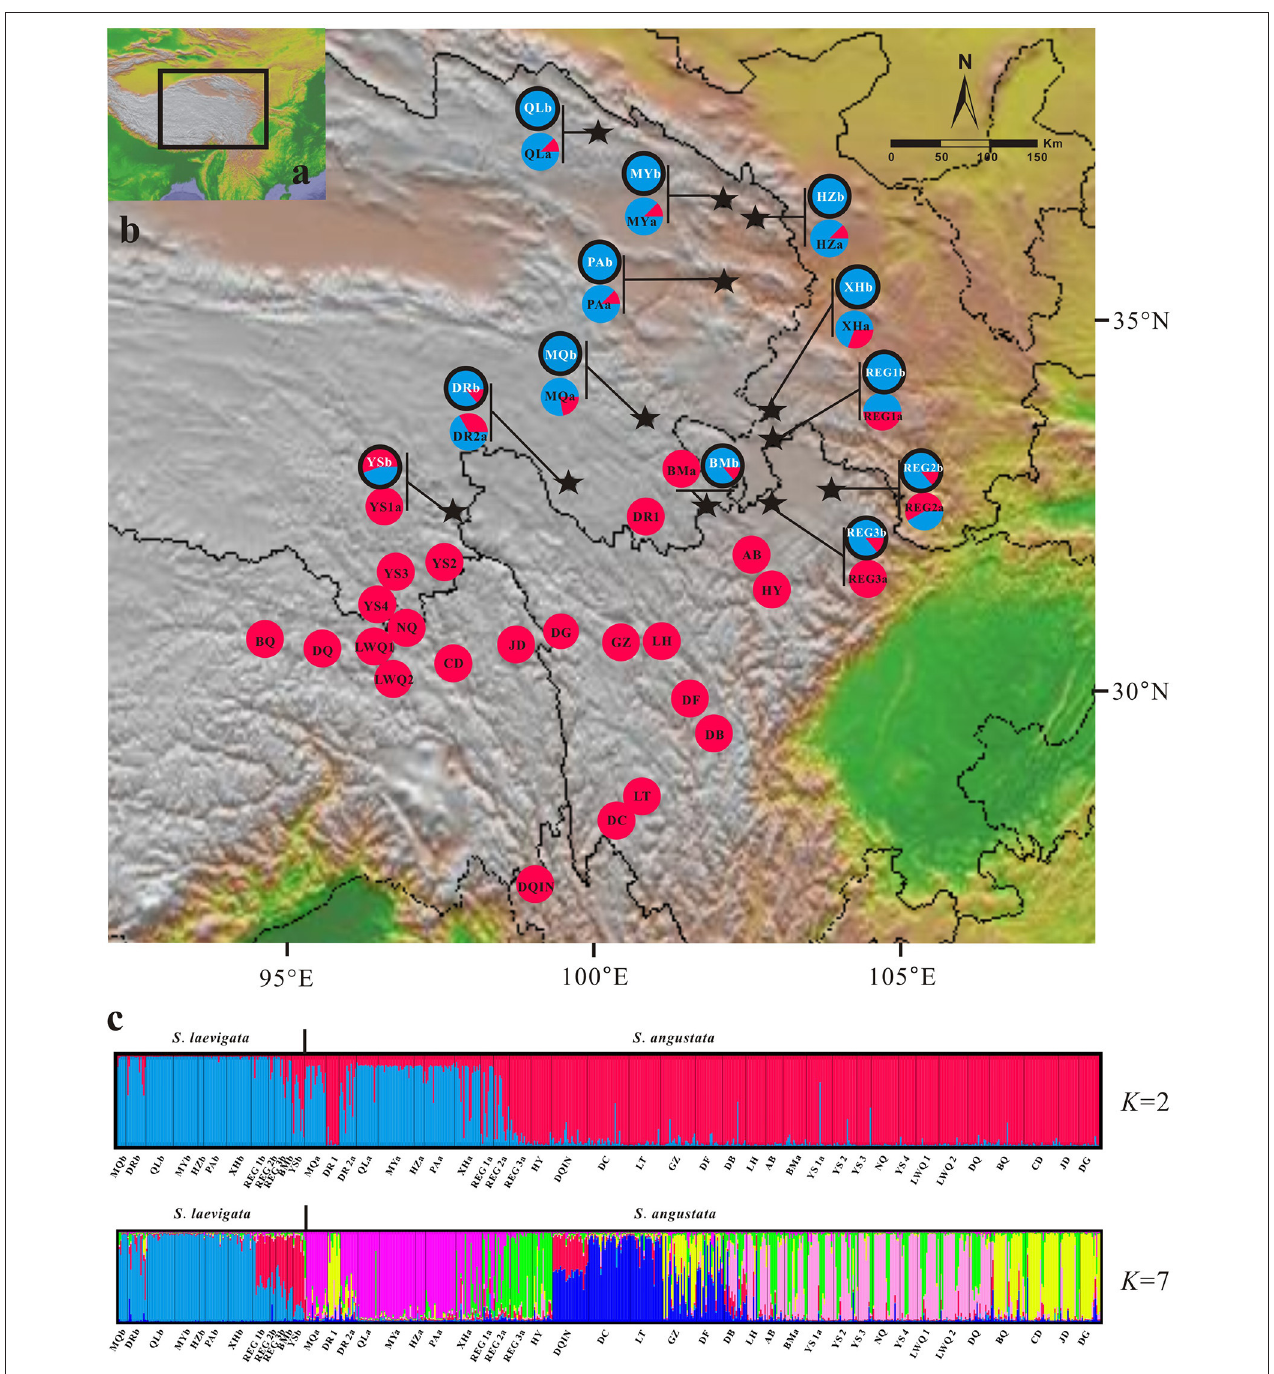
FIGURE 1 | Genetic structure of Sibiraea populations in the Qinghai-Tibetan Plateau. (A) Sampling area; (B) Genetic structure of Sibiraea populations based on K = 2 genetic clusters; (C) Proportional membership of 55 Sibiraea populations to K = 2 and 7 genetic clusters. Individuals are represented by a single vertical column divided into 2 or 7 ( = K ) colors. The relative length of the colored segment corresponds to the individual’s estimated proportion of membership in that cluster.